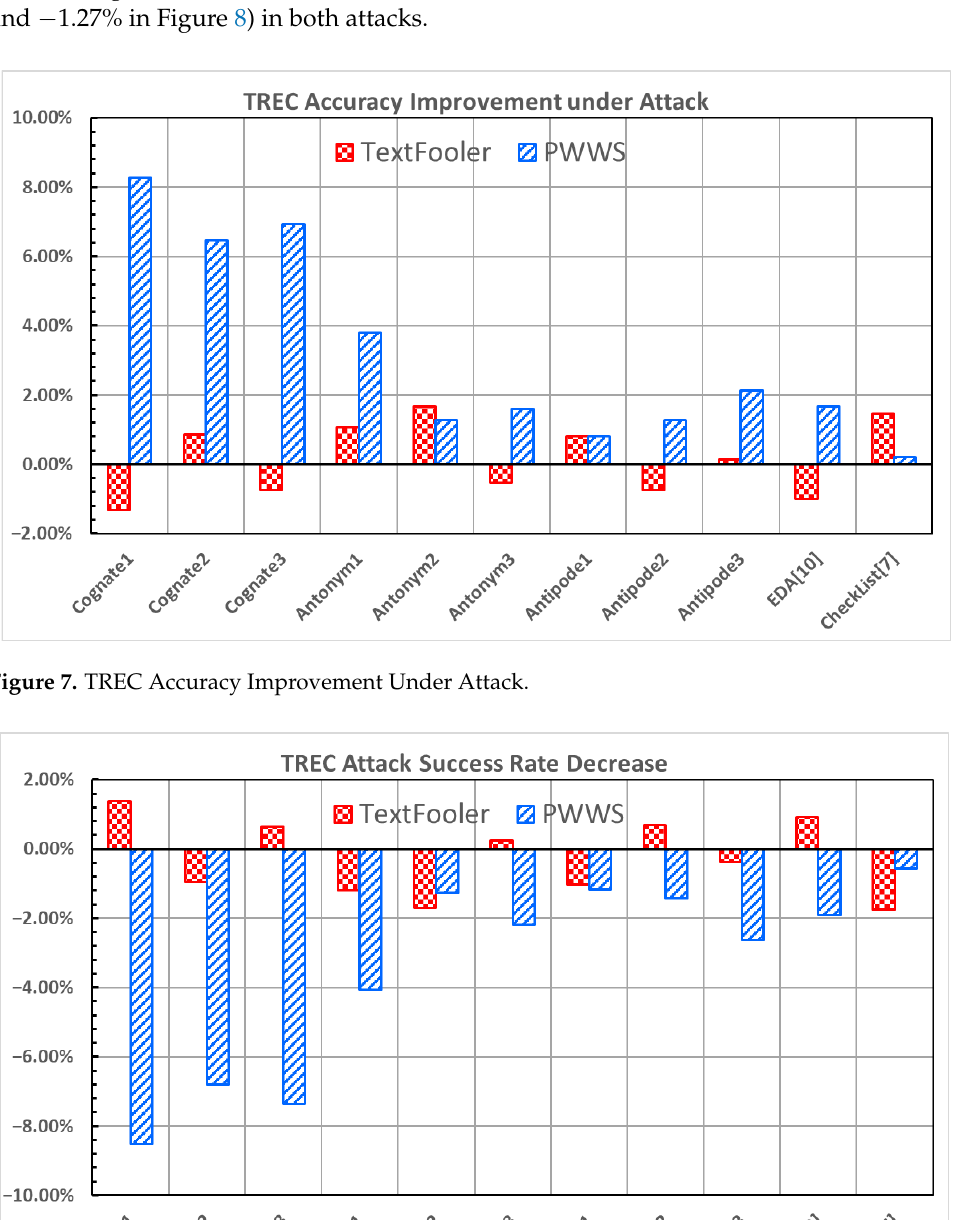
Figure 6. AG-News Attack Success Rate Decrease.